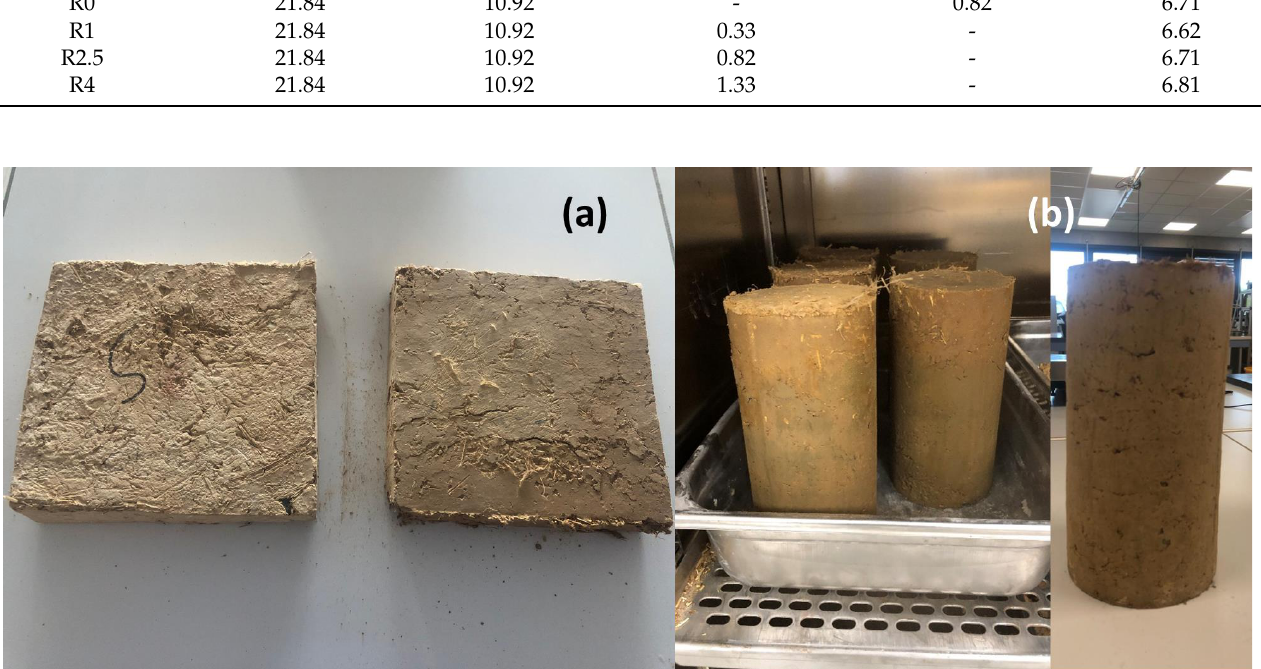
Table 7. Composition of the mixture.